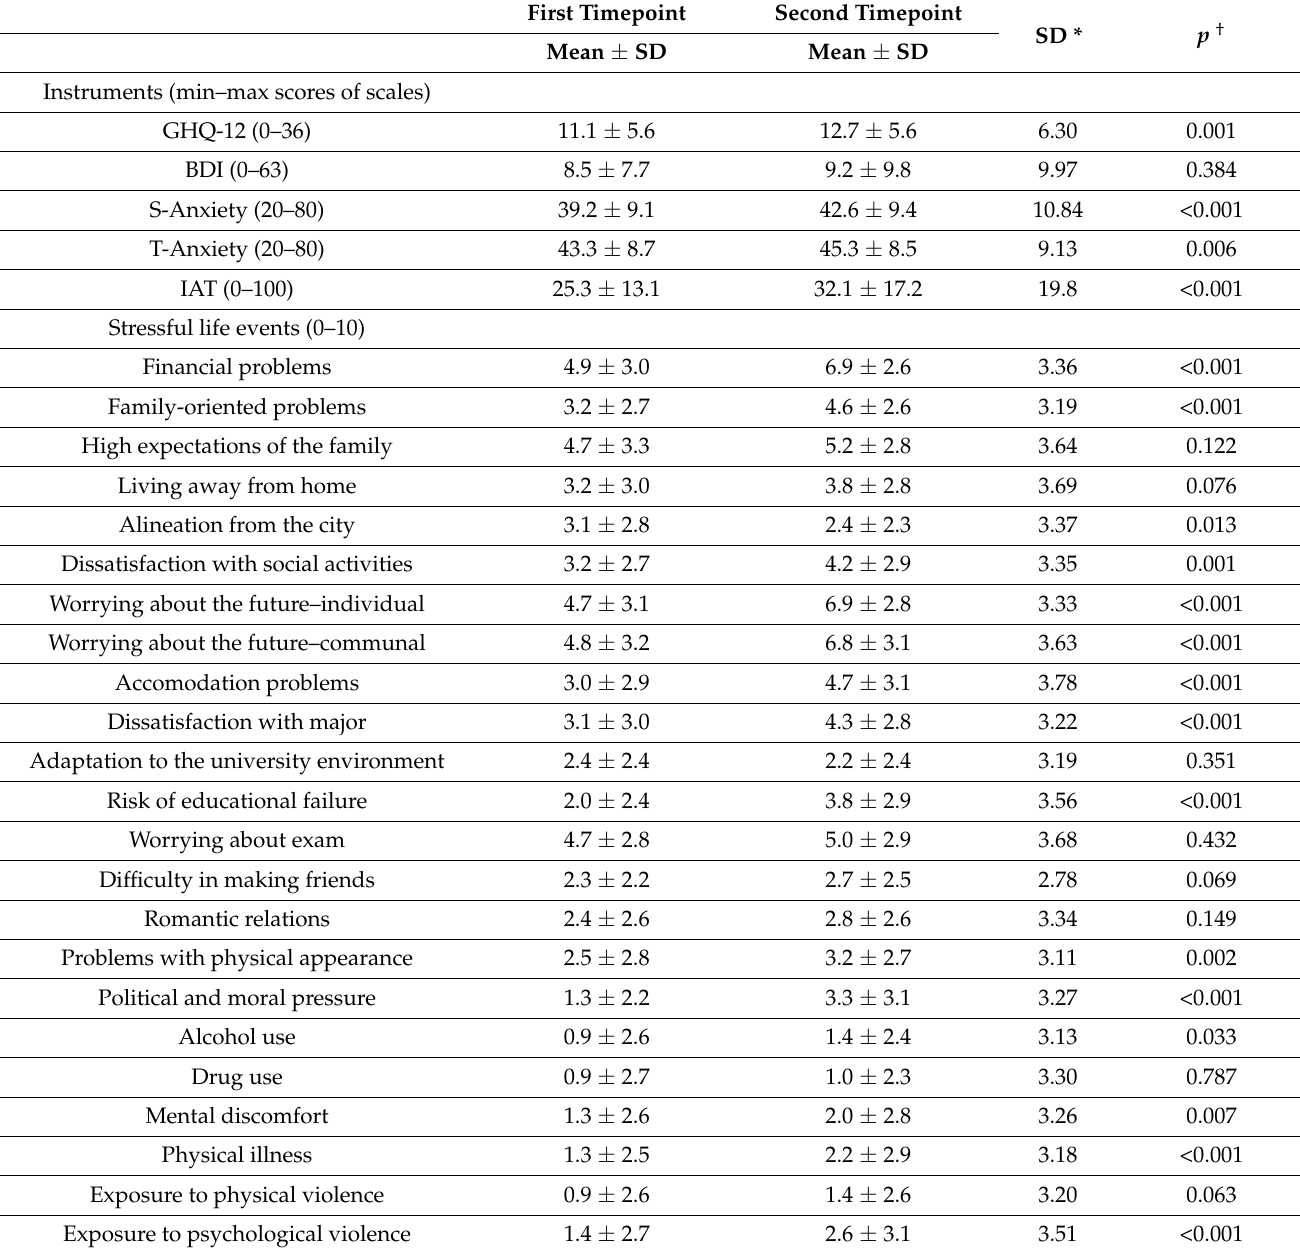
Table 2. The scores of nursing students from the scales in the first and second timepoints and their perception of stressful life events ( n =